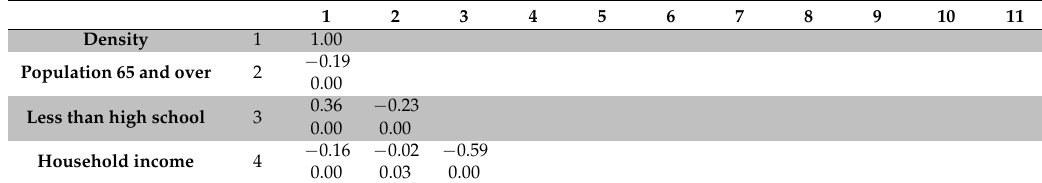
Table 4. Correlation analysis of variables in census tracts in coastal